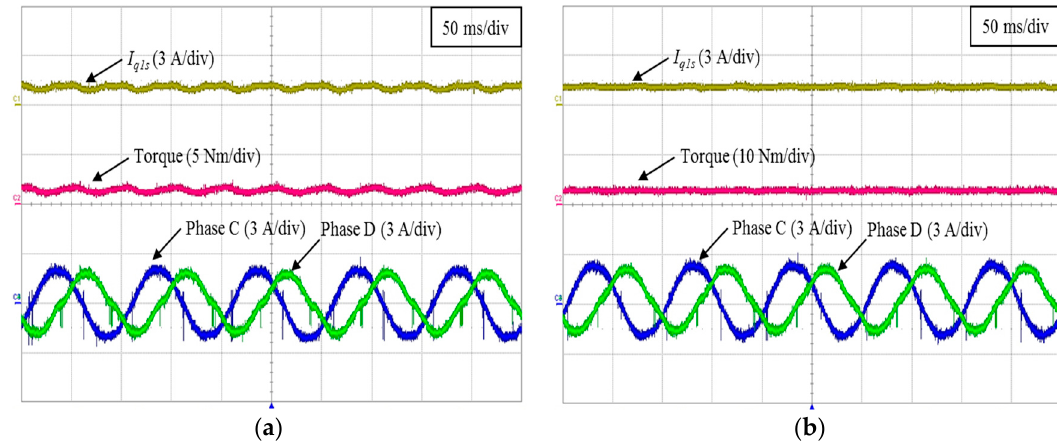
Figure 16. Experimental result of fault ‐ tolerance under open fault phases B in i q1s = 1 A and 300 rpm: ( a ) Without tolerant control; ( b ) With tolerant control.